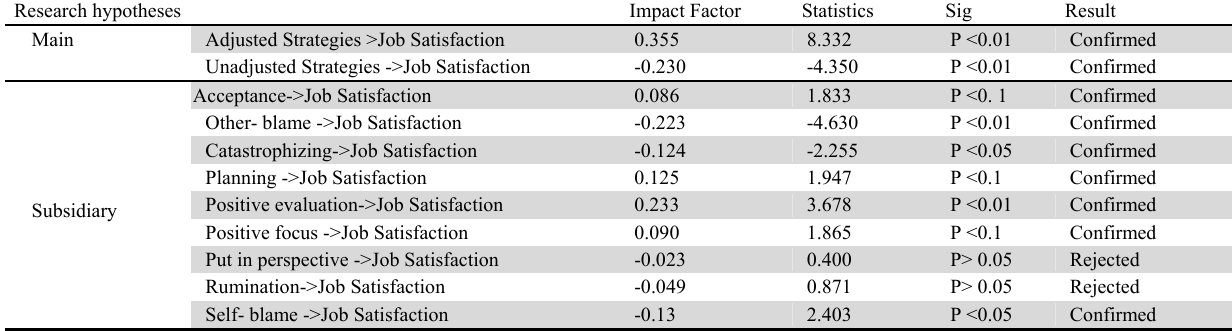
Path coefficients, t-statistics and the results of research